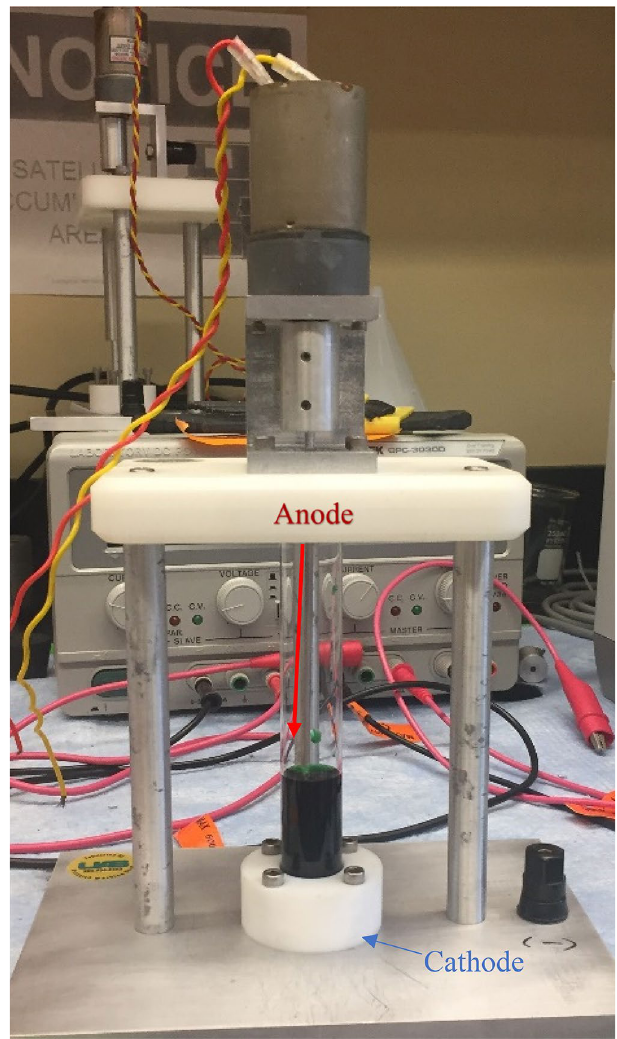
Figure 2. Electroplating apparatus used to plate Cr metal from a CrCl 3 solution where the cathode is located between the base plate and the plastic coin holder. The anode is the platinum rod which can be seen connected to the motor and suspended in the CrCl 3 plating solution.